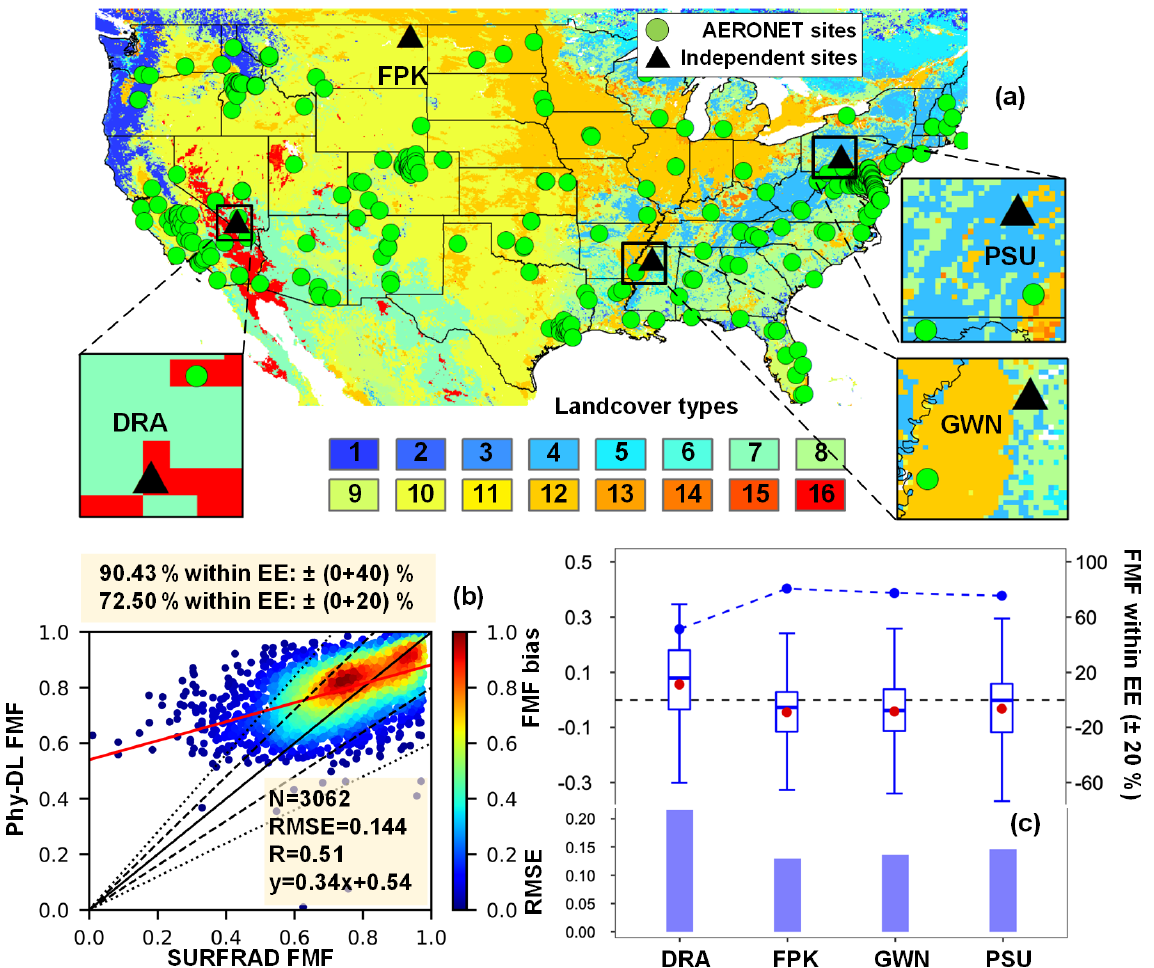
Figure 5. (a) The locations of AERONET sites (green points) and four independent SURFRAD sites (black triangles) for the independent validation of the Phy-DL FMF algorithm. The base map shows the land types from MODIS MCD12C1 data (the International Geosphere- Biosphere Programme scheme, Table S4). (b) Phy-DL FMF at 500nm as a function of SURFRAD FMF. The solid black and red lines are the 1 : 1 line and the best-fit line obtained from linear regression, respectively. The dashed and dotted black lines represent the expected error (EE) envelopes of ± 20% and ± 40%, respectively. (c) Boxplots of bias (Phy-DL FMF minus SURFRAD FMF), percentage of FMF estimates falling within the EE envelope of ± 20% (dashed-dotted lines), and RMSEs at the four independent SURFRAD sites. The upper, middle, and lower lines in each box present the 75th, median, and 25th percentiles, respectively. The red point in each box represents the mean value of the FMF bias. DRA = Desert Rock, FPK = Fort Peck, GWN = Goodwin Creek, PSU = Penn